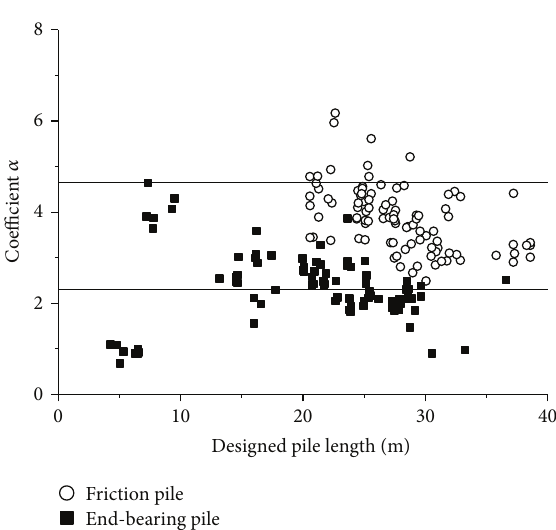
Figure 9: Typical coefficient 𝛼 of bridge piles (188 samples).